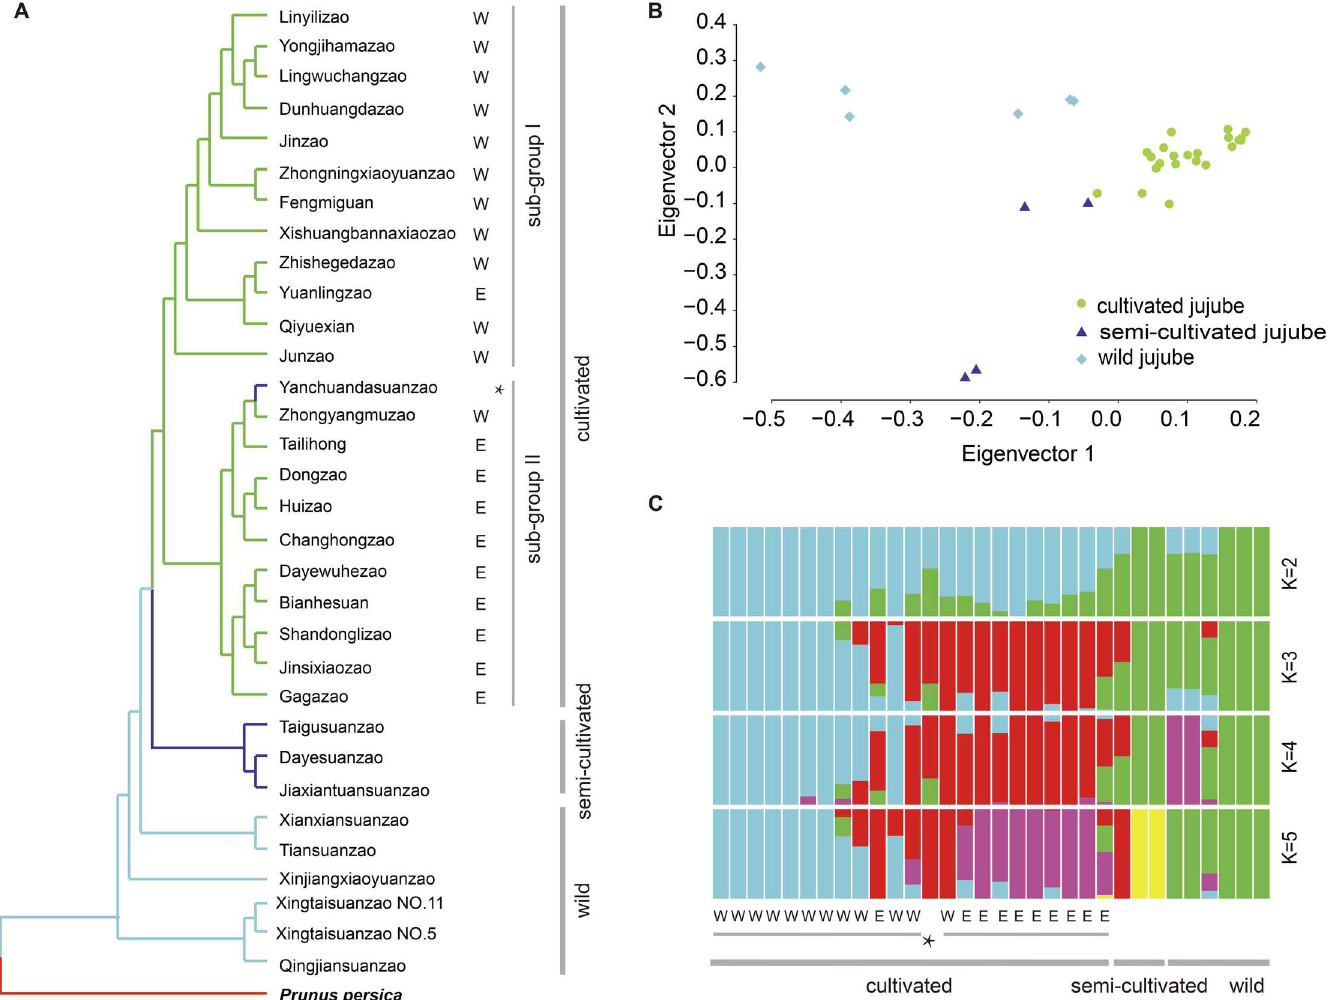
Fig 2. Jujube population structure. (A) Neighbor-joiningphylogenetic tree of jujubeaccessions based on whole-genomeSNP data. The jujube accessions are marked with E (east) or W (west), indicating their geographicaldistributions. (B) PCA of cultivatedand wild jujubepopulationsusing whole- genomeSNP data. ( C ) Populationstructure analysisof jujubeaccessionsusing FRAPPE at multiple kinshiplevels (K = 2, 3, 4 and 5). Each vertical bar representsone jujubeaccession.The length of each colored segment in each vertical bar representsthe proportioncontributedby ancestralpopulations. The accession marked with * in part A corresponds to the wild jujube‘Yanchuandasuanzao’.